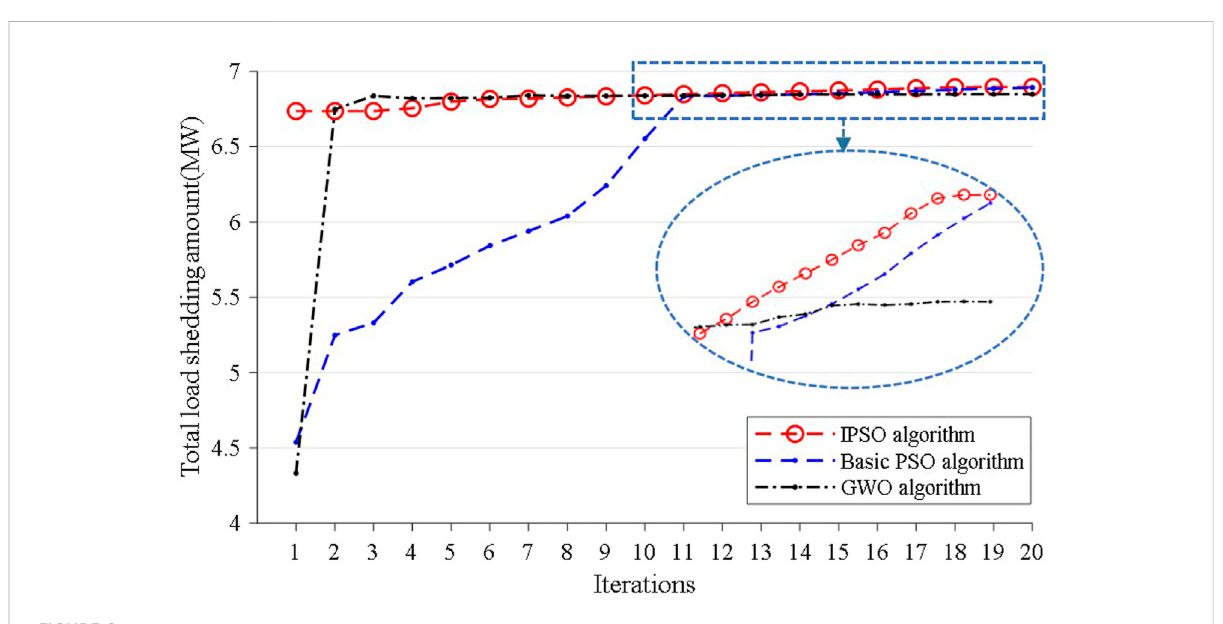
FIGURE 8 Convergence curves of three algorithms.